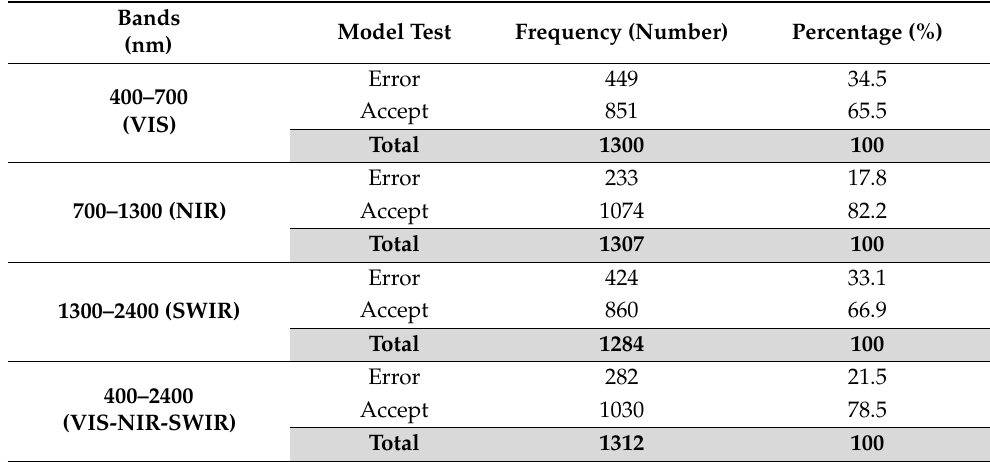
Table 1. STEPWise models indicating error acceptance and frequency and by model-based VIS-NIR- SWIR comprising reflectance